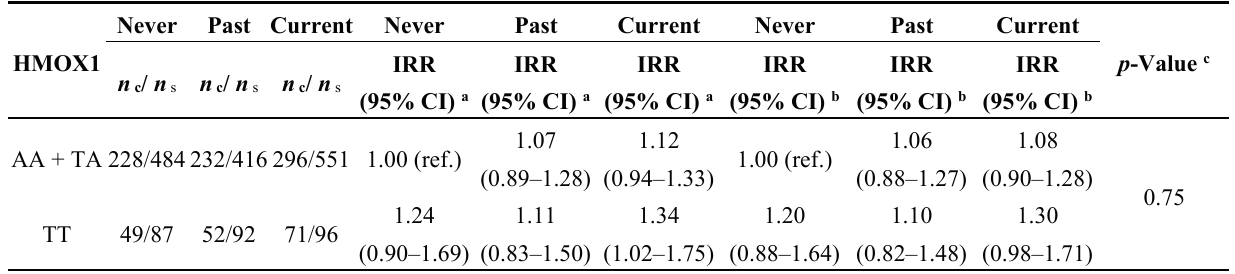
Table 6. Interaction between smoking status and HMOX1 A-413T (rs2071746) in relation to risk of colorectal